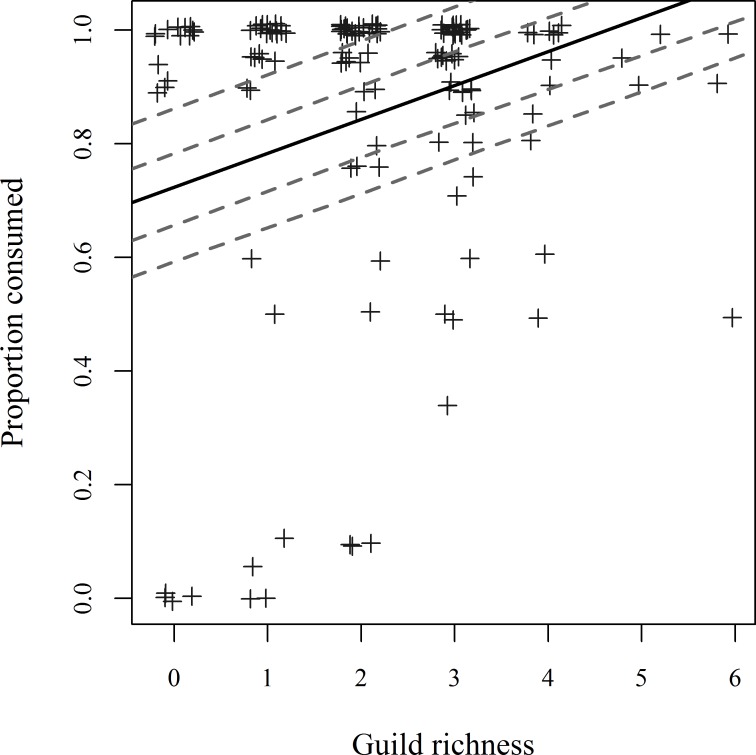
Linear relationship between carcass removal and richness of local vertebrate scavenger guild.Proportion of carcass consumed by the end of 1-month trials related to local vertebrate scavenger guild richness at each carcass. Hashed lines represent random intercepts for each season based on a linear mixed effect model. The solid line represents the fixed effect (estimate ± 1SE = 0.0597 ± 0.0170).